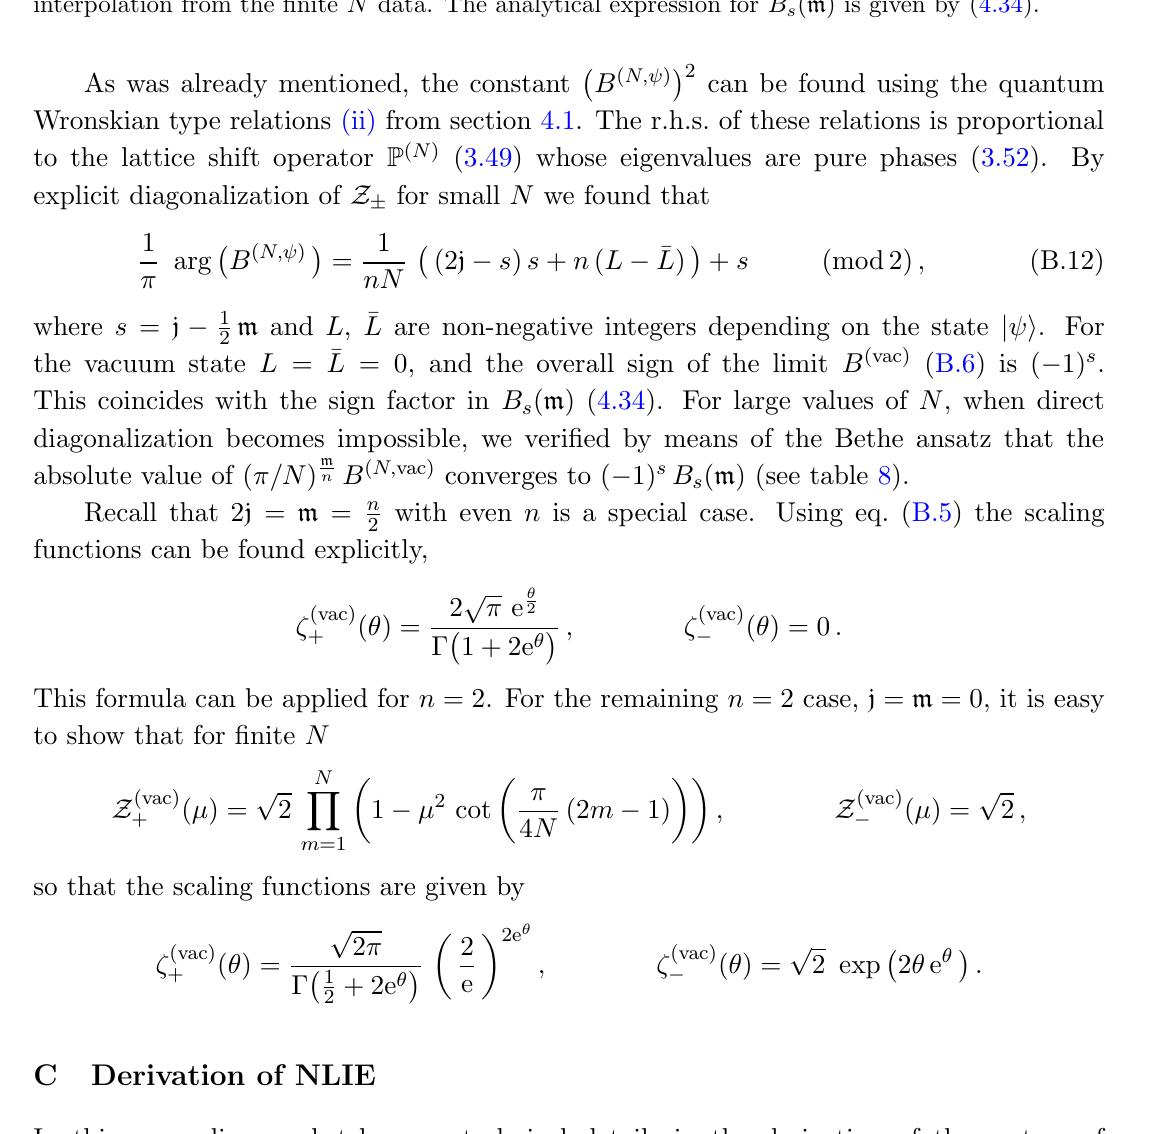
Table 8 . The absolute value of ( (cid:25)=N ) m n B ( N; vac) corresponding to the vacuum state of the Fateev- Zamolodchikov spin chain (3.47), (3.48). The column \ N = 1 " contains the results of